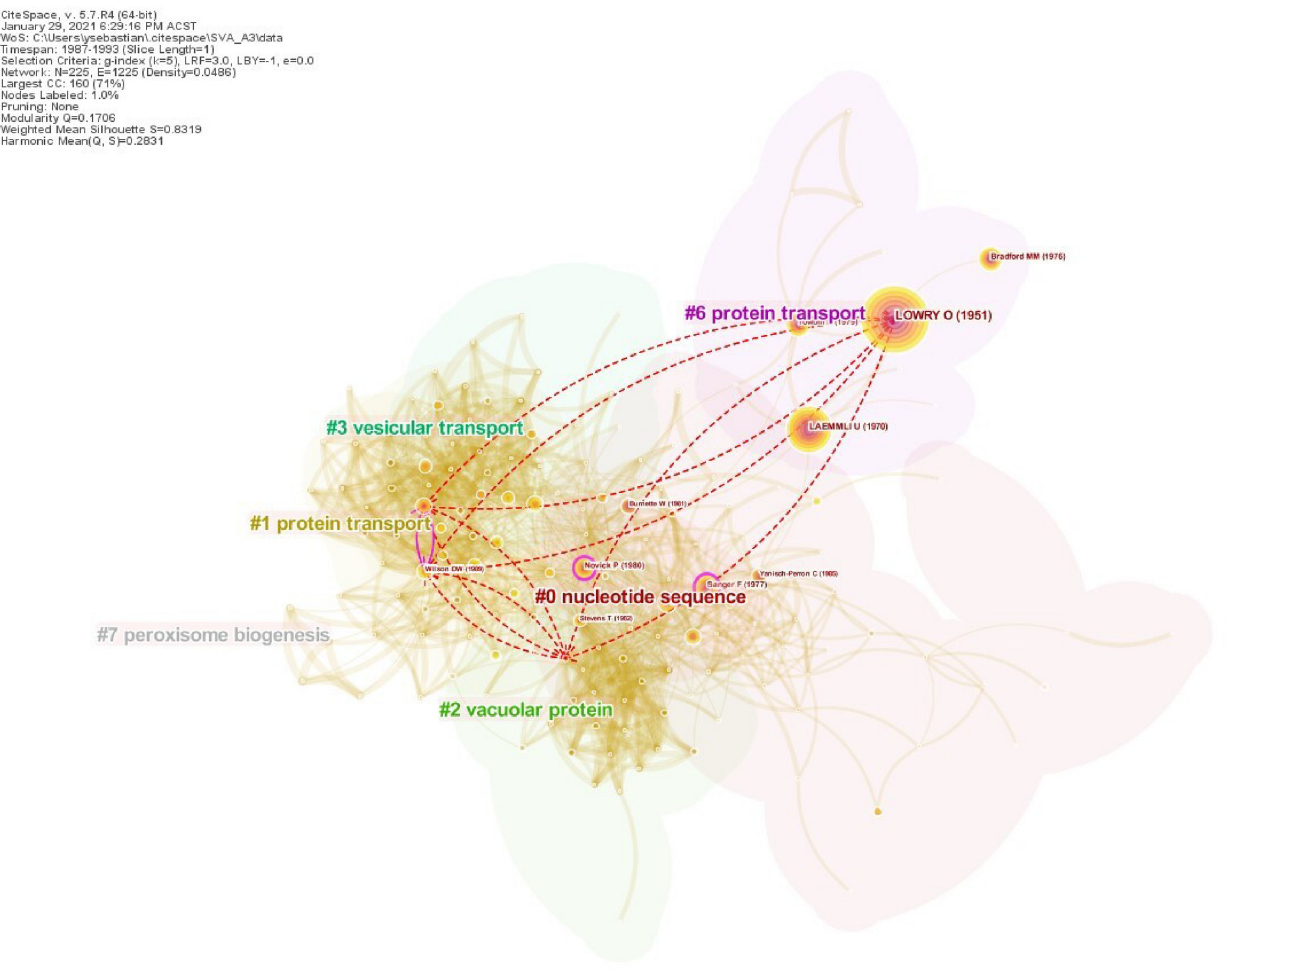
Fig 6. Case 3, Seed 1 ( S 3,1 ). The co-citation network surrounding Ohsumi’s breakthrough papers (1987–1993), showing novel links added by S 3,1 [58]. Cluster labels were generated with log-likelihood ratio and the node sizes correspond to the degree of betweenness centrality of a cited